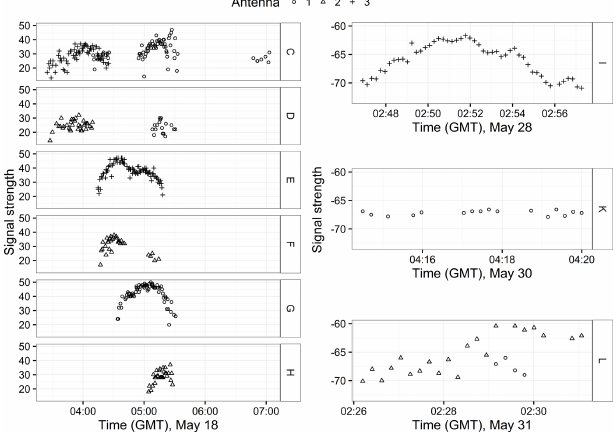
Fig. 5 . Raw signal strength data for a radio-tagged Swainson’s Thrush ( Catharus ustulatus ) detected at Motus stations C-H, I, K, and L (Fig. 4) after departing on migration from its overwintering site in Colombia on 29 April 2016 (Gonzalez and Hobson, unpublished data ). Clear parabolas in signal strength values suggest the individual passed directly through (perpendicular to) the antenna beam, whereas a more consistent signal strength suggests the individual is flying in the same direction as the antenna beam. Signal strength values are not directly comparable between plots on the left and right because data were collected using Lotek receivers on the left, and using Sensorgnome receivers on the